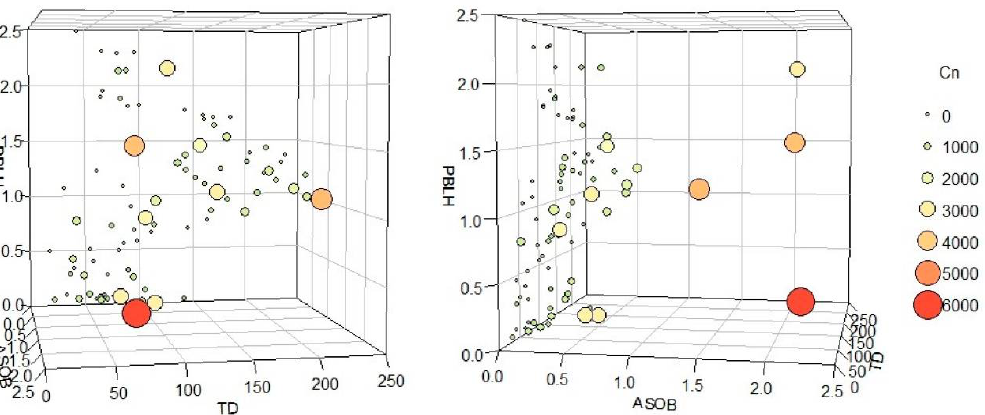
Figure 12. Distribution of burning area, transport distance, average PBLH along the transport path- way, and the corresponding PM 2.5-inflow concentration in the HWFGs during each PE. Note: ASOB, TD, and PBLH in the figure represent the area of the SOB (ha), the transport distance (km), and the PBLH along the transport pathway (km). C n is the corre- sponding PM 2.5-inflow concentration (μg m −3